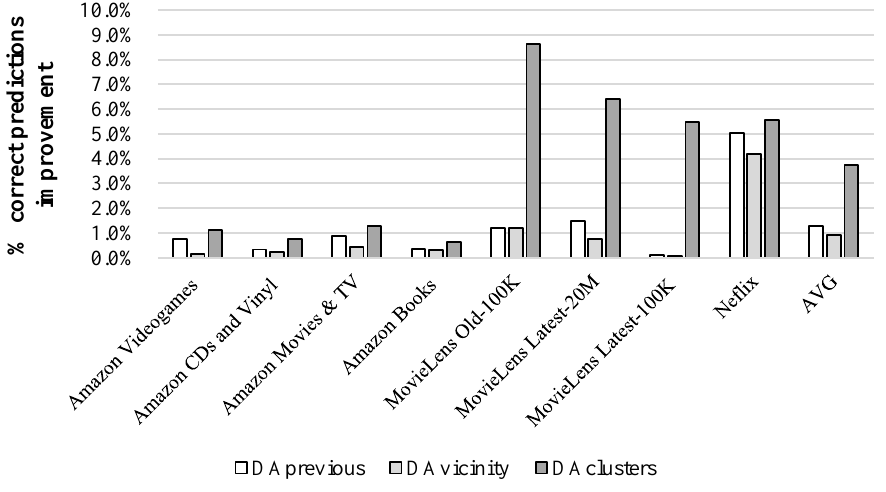
Figure 3. Correct predictions percentage improvement achieved by the DA